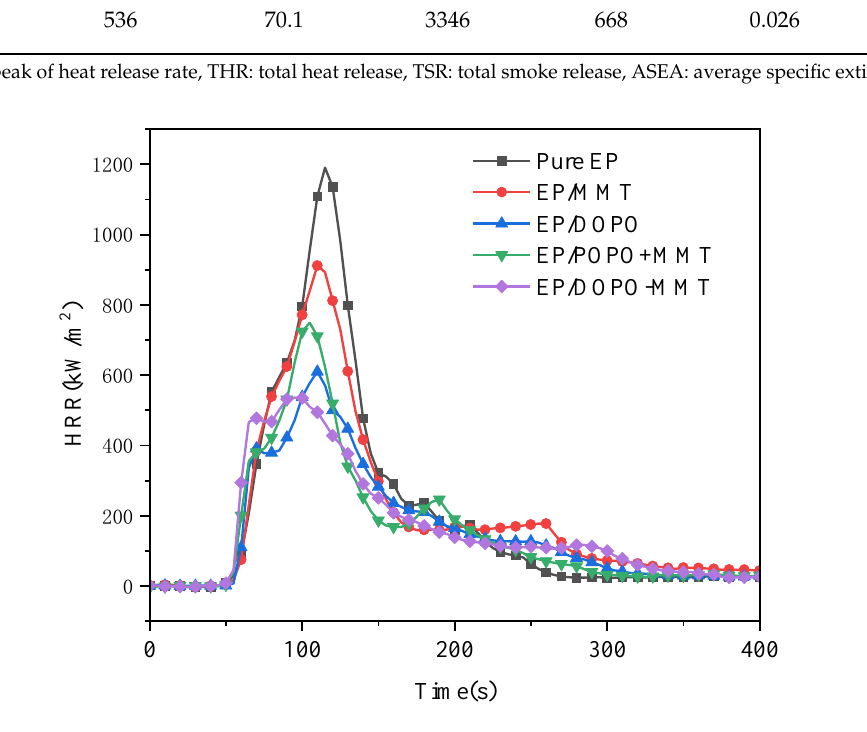
Figure 9. THR curves of epoxy resin composites. The semi-quantitative calculation of the synergistic effectivity(SE) can be calculated by Equation (1) [33]. It enables a clear differentiation between synergism, cooperation,